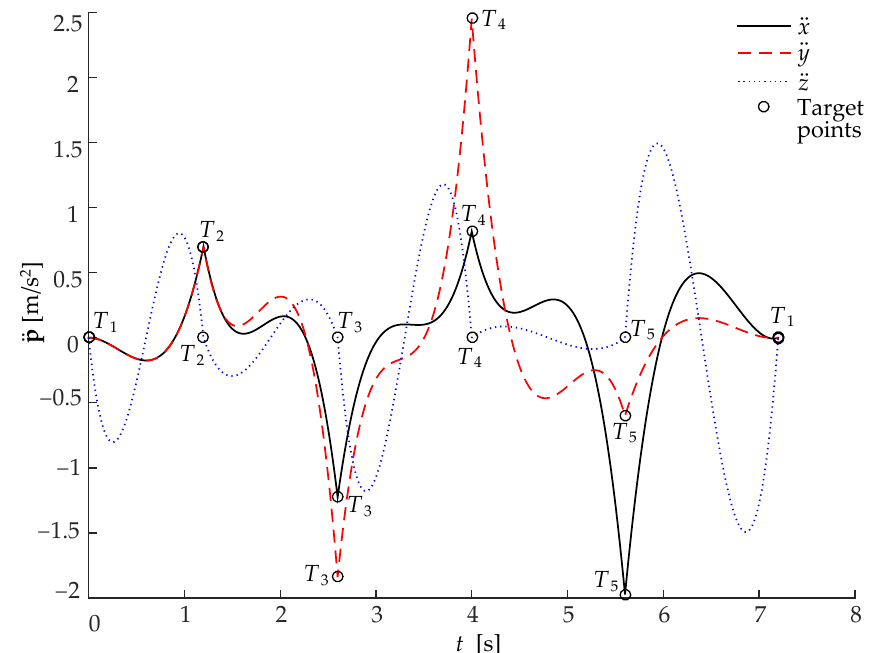
Figure 12. As Figure 11, for the trajectory defined by fifth-order polynomial